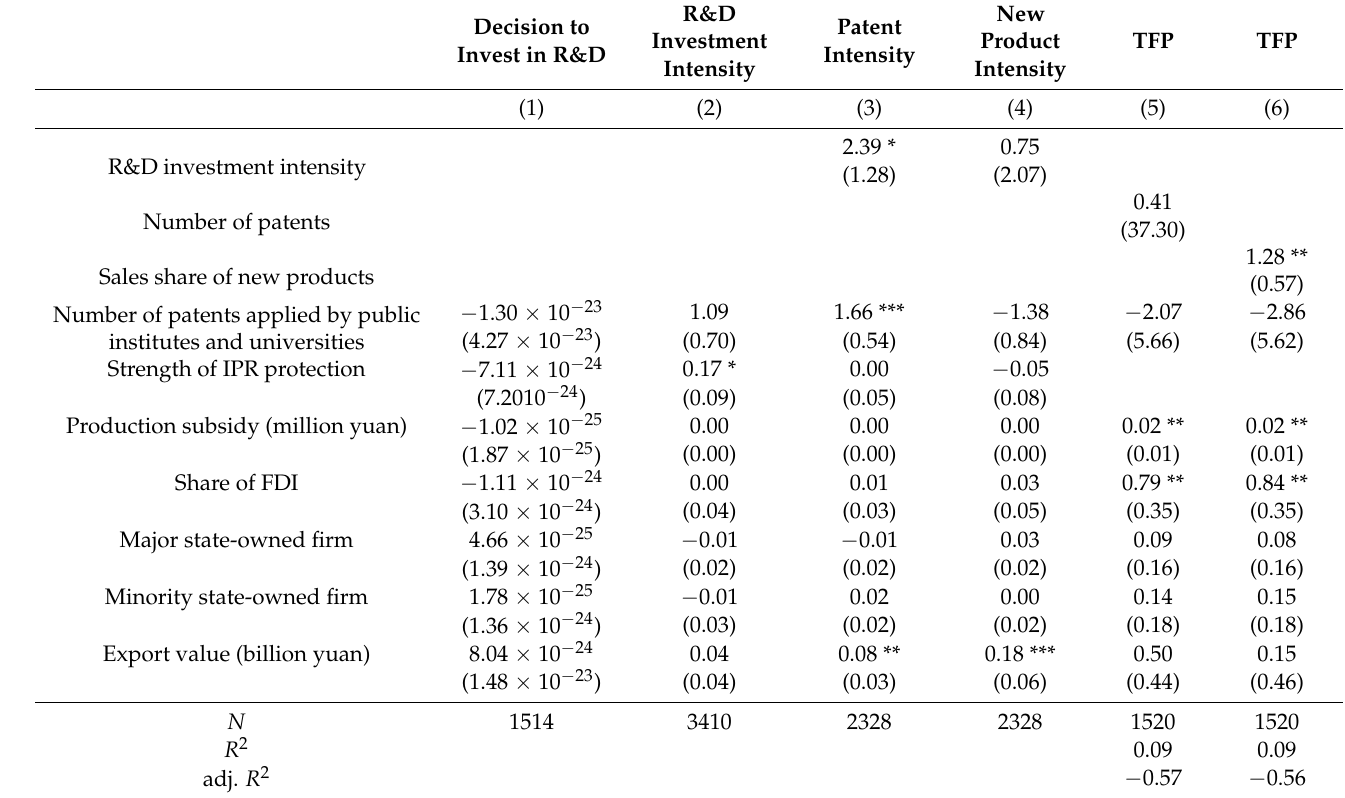
Table 7. R&D investment, innovation output, and productivity